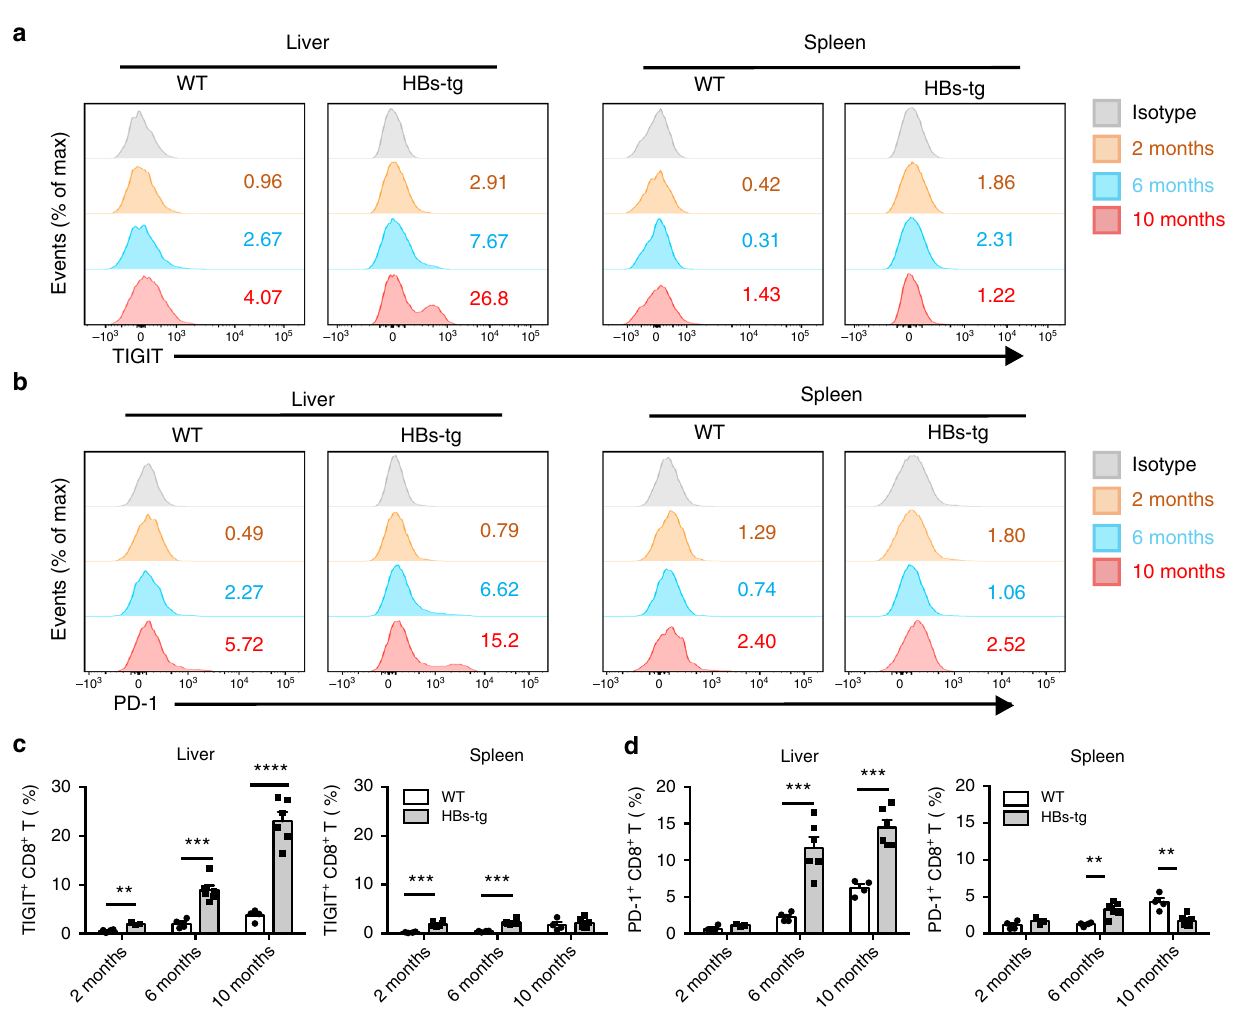
Fig. 4 Gradually increased expression of TIGIT on CD8 + T cells in the liver of HBs-tg mice. a Representative fl ow cytometric graphs showing TIGIT expression on CD8 + T cells in the liver and spleen of 2, 6, and 10-month-old WT and HBs-tg mice. Numbers indicate the percentages of TIGIT + cells among CD8 + T cells. b Representative fl ow cytometric graphs showing PD-1 expression on CD8 + T cells in the liver and spleen of 2, 6, and 10-month-old WT and HBs-tg mice. Numbers indicate the percentages of PD-1 + cells among CD8 + T cells. c The statistical percentages of TIGIT + cells among CD8 + T cells in ( a ) are shown ( n = 3 – 6 in each group). d The statistical percentages of PD-1 + cells among CD8 + T cells in ( b ) are shown ( n = 3 – 6 in each group). Statistically signi fi cant differences between the groups are presented as the mean ± SEM. ** P < 0.01; *** P < 0.001; and **** P < 0.0001 (two-tailed unpaired Student ’ s t -test). Data are pooled from three independent